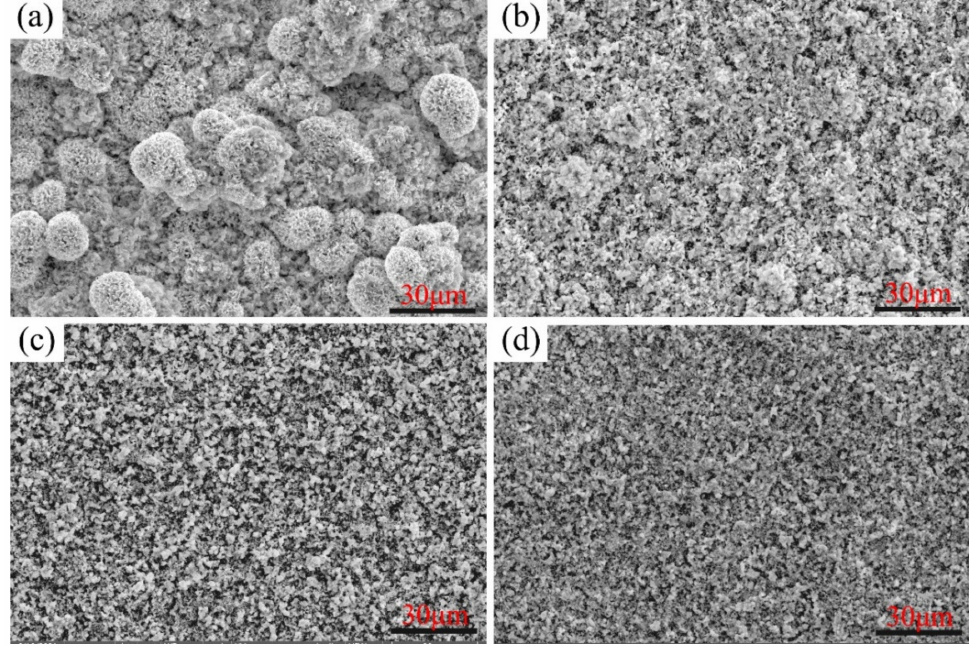
Figure 6. Secondary electron morphology of Ni–xCr–Mo laser-cladding coatings corroded for 168 h at 500 ◦ C: ( a ) C1, ( b ) C2, ( c ) C3, and ( d )